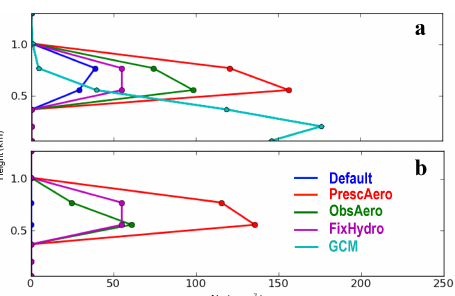
Figure 1. Profiles of in-cloud droplet number concentrations ( N d ) for DYCOMS RF02. GCM values are July climatologies extracted from a 10-year-long prognostic-aerosol GCM run at the location of DYCOMS RF02. (a) is for runs where condensate is detrained (the default model behavior) and (b) shows runs where all detrained water is in vapor